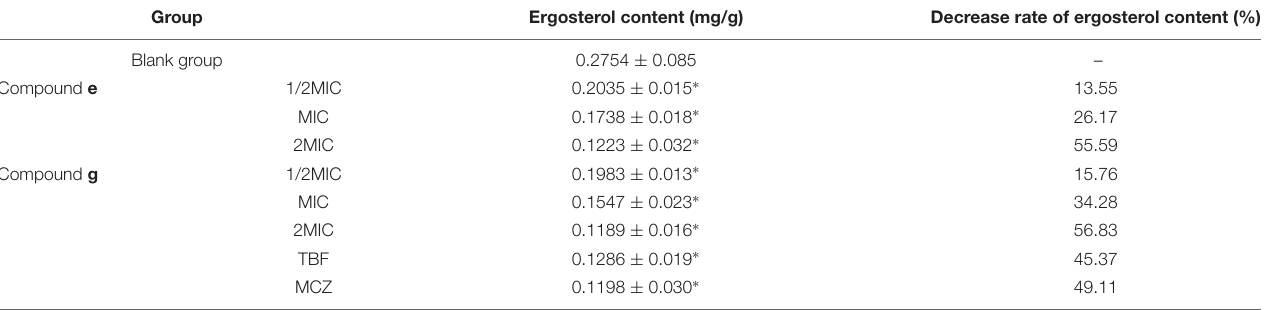
TABLE 2 | Effects of different concentrations of drugs on ergosterol in Microsporum canis.